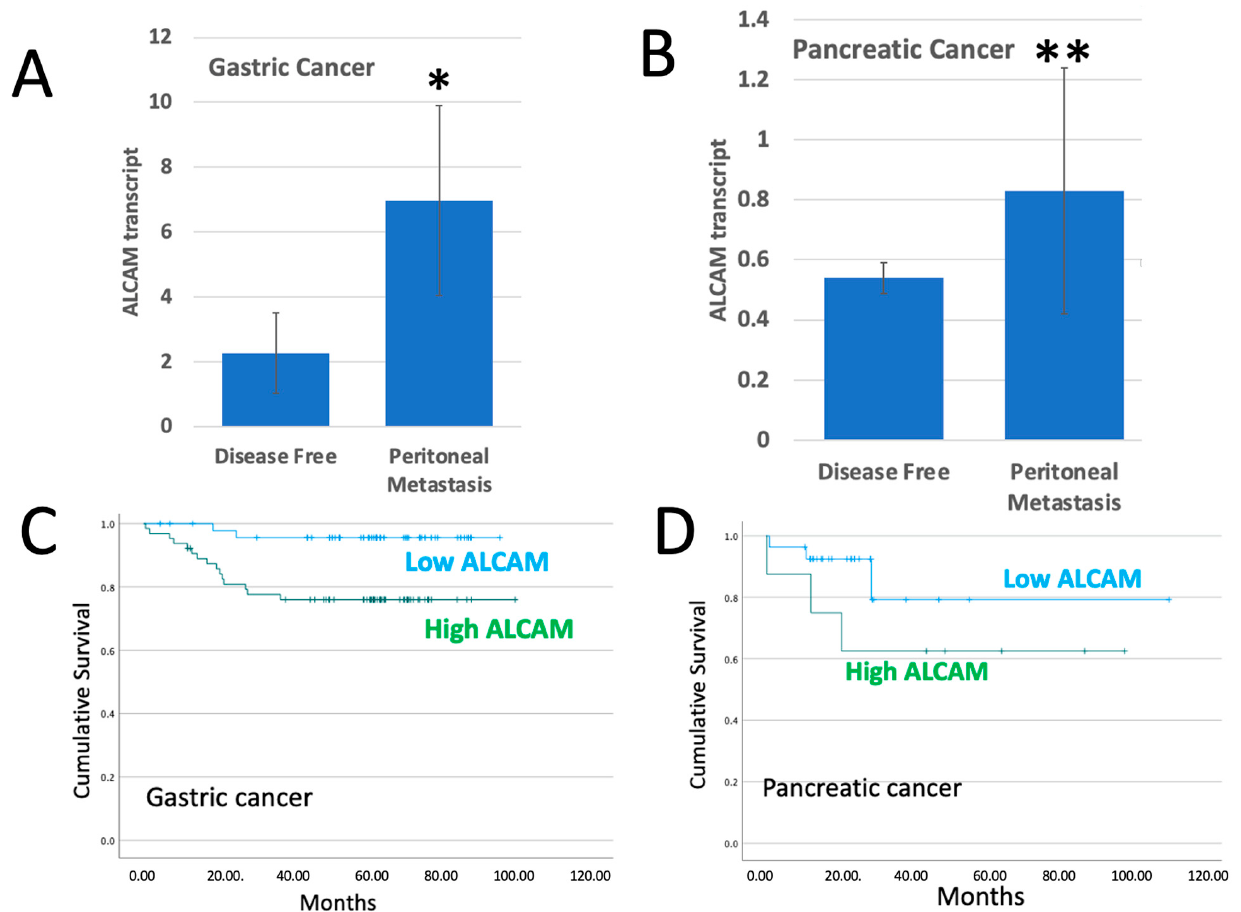
Figure 1. ALCAM transcript expression in tumours ( A , B ) and in relationship with peritoneal metastasis free survivals ( C , D ). ( A , B ): The ALCAM levels were compared between tumours from patients who remained disease-free and those who developed peritoneal metastases ( n = 18 with peritoneal metastasis and n = 112 who were disease free for the gastric cancer group and n = 6 and n = 35 for the pancreatic cancer group). * p = 0.037, ** p = 0.01. ( C , D ): Gastric cancer patients with high levels of ALCAM had a significantly shorter survival than those with low levels ( p = 0.006). A similar shorter survival with seen with pancreatic cancer patients although this is yet to reach statistical significance ( p = 0.208). Table 1. ALCAM and patient’s peritoneal metastasis-free survival in gastric and pancreatic cancer.